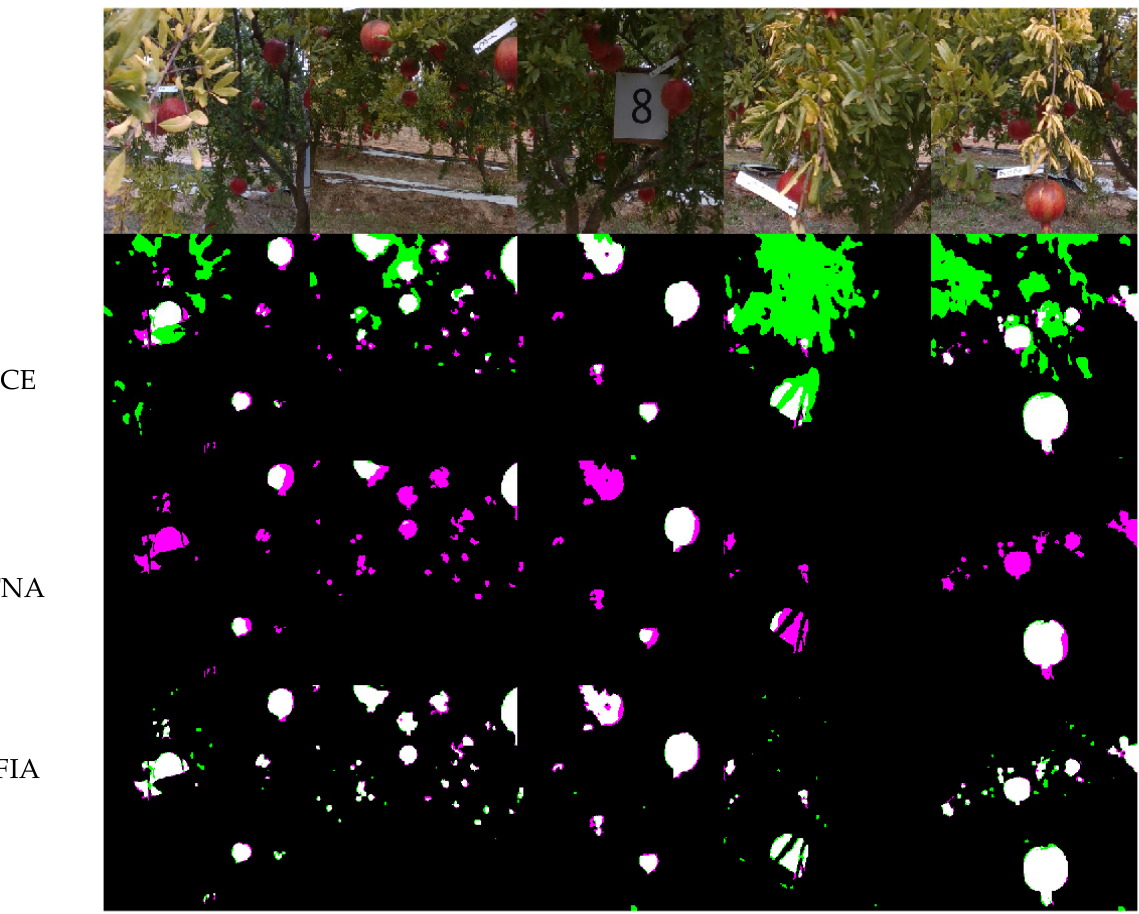
Figure 13. Comparison among segmentation results obtained from the three different approaches. White pixels represent true positives, black pixels represent true negatives, pink pixels represent false negatives and green pixels represent false positives.